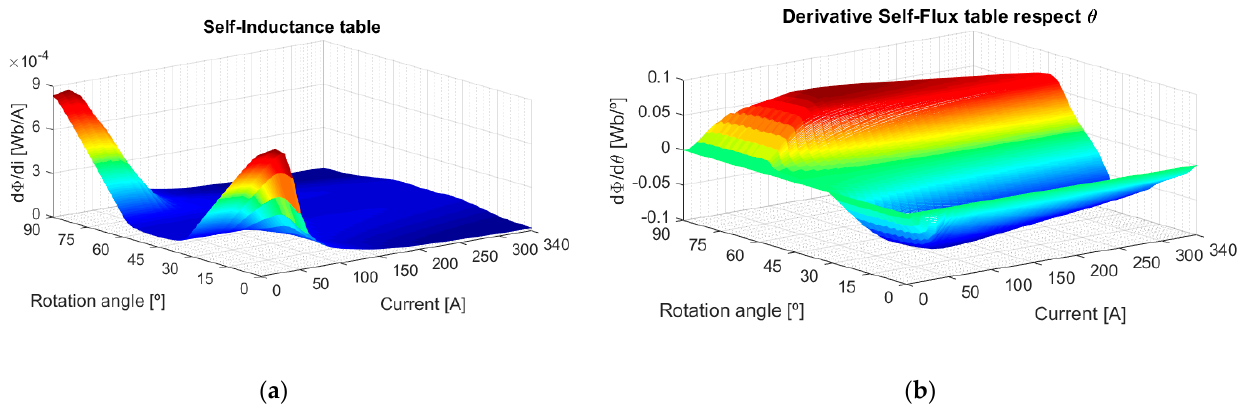
Figure 11. ( a ) Self-inductance table (i.e., self-flux derivative map with respect to phase current as a function of the current and mechanical angle); ( b ) self-inductance derivative map with respect to mechanical angle as a function of the current and mechanical angle.